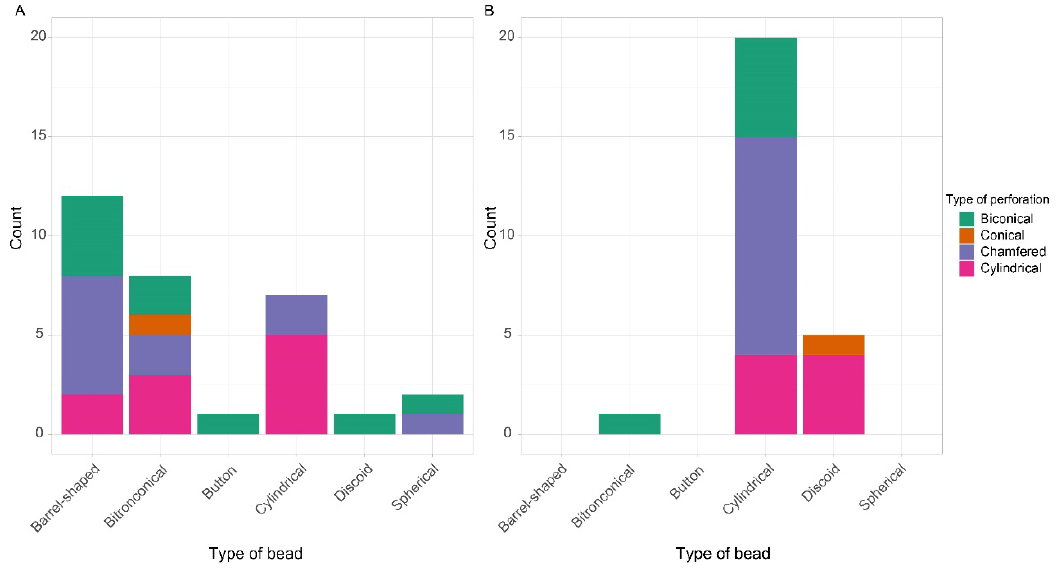
Figure 8: Types of perforation according to the type of amethyst (A) and rock crystal (B) beads. Data and script to reproduce this figure are available at https://osf.io/zyhb7/ X-ray microtomography images of the selected amethyst beads from Morel and Anse à la Gourde (GD- 02-038, GD-02-025 and GD-08-001) demonstrate how efficient and useful is this method to highlight the morphology of the perforations. The perforation of the selected beads are all biconical and join in the center of the bead with a slight offset (Figure 9). The perforations are narrow and not very tapered. The junction of the two sides of the perforation shows a smaller diameter for two beads (GD-02-038 and GD- 02-025) indicating that the final few millimeters of drilling was made with a thinner drill bit. The